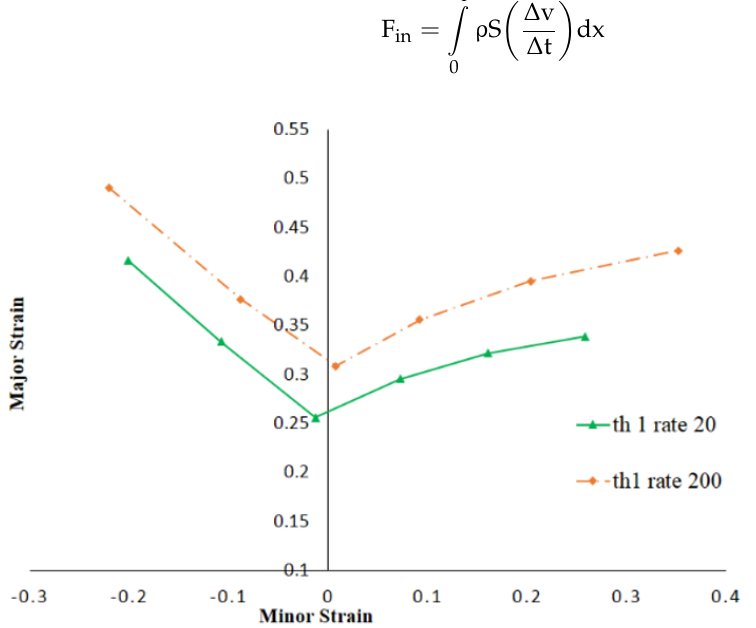
Figure 13. FLDs at different speeds for a 1 mm-thick sheet.